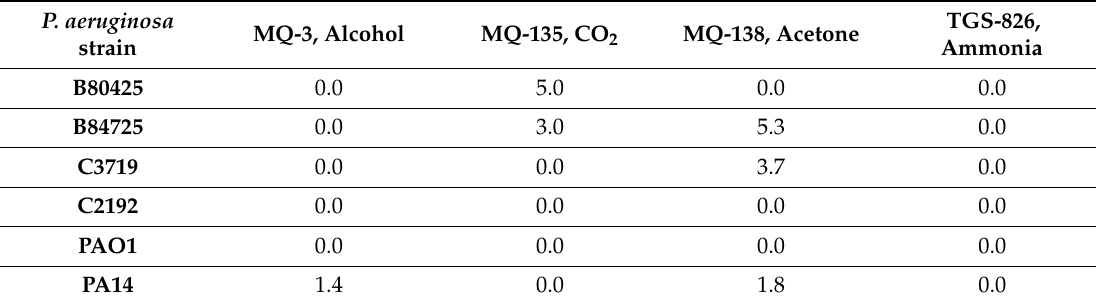
Table A3. Mean values of the P. aeruginosa solid samples at 7.5